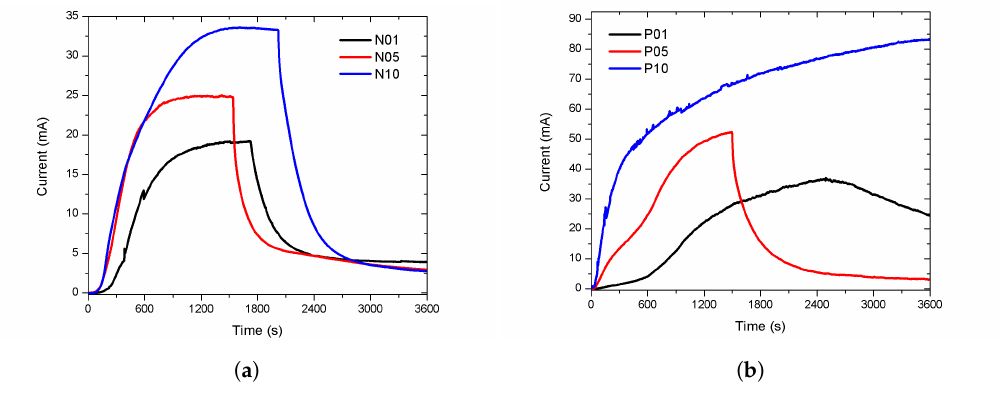
Figure 5. The stability of the response. The sensors were exposed to EtOH vapour for an extended duration (more than two hours) arbitrarily. ( a ) The response of the n-type porous sensors.The responses reached stability and they recovered when the flow of EtOH stops. ( b ) The response of the p-type porous. The stability was not achieved. The exposure was stopped after 2, 4, and 6 h for P05, P01, and P10, respectively. Only the recovery of P05 was observed, due to the long time of the measurements. Finally, the sensors with a lower response intensity, N01 and P10, for each type of conductivity, were selected to be measured in a lower ambient vapor pressure (less EtOH carried into the